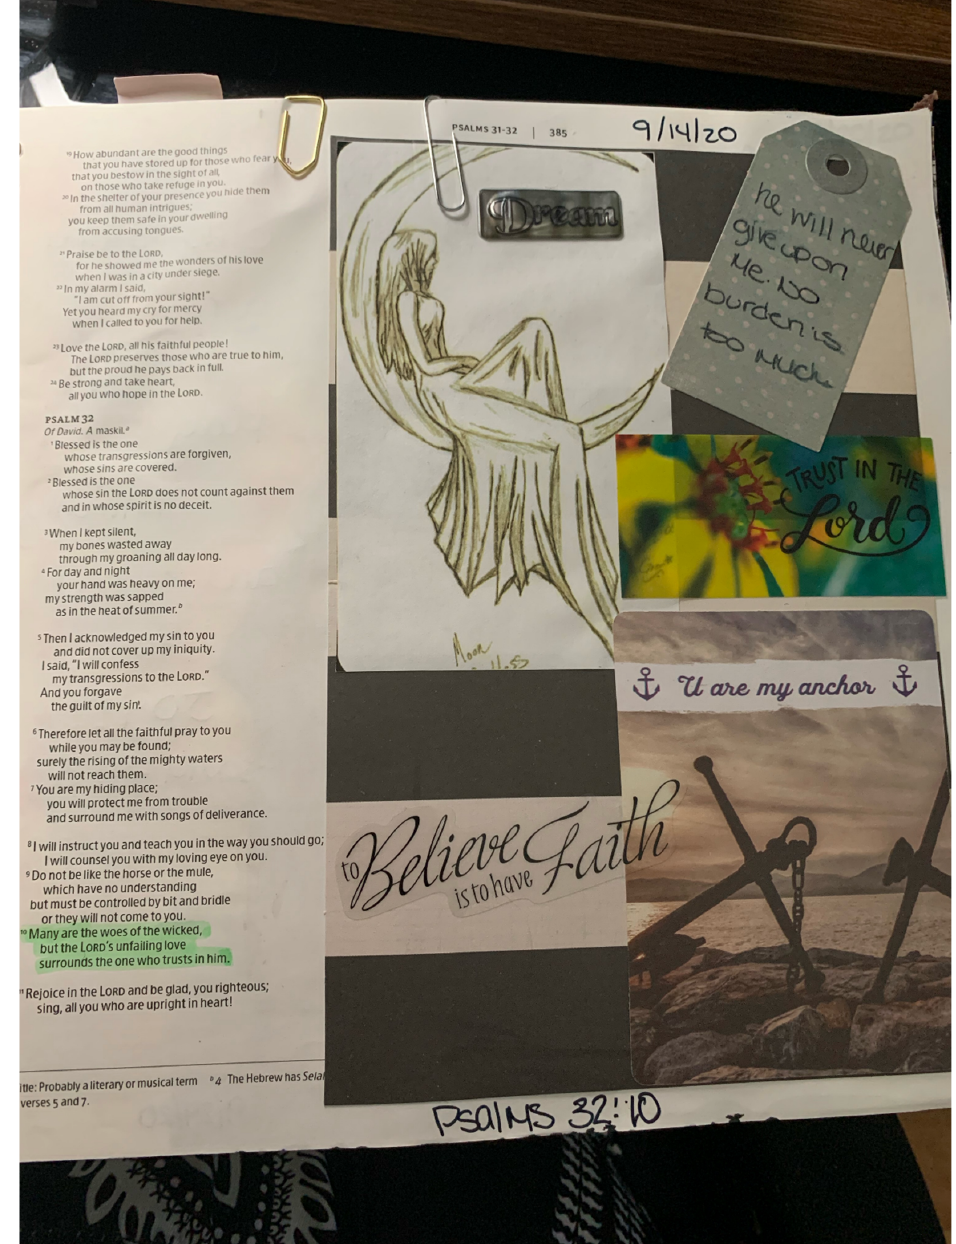
Figure 4. Psalm 32:10. With kind permission of the journaler.